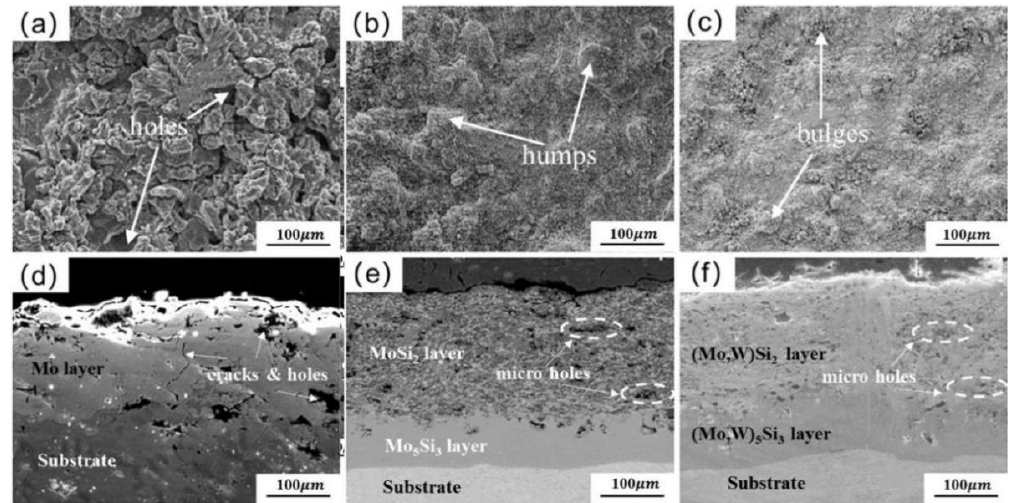
Figure 5. SEM images of coatings prepared by SPS under different procedures: ( a , d ) Pure Mo coating; ( b , e ) MoSi 2 -mullite coating; ( c , f ) WSi 2 -mullite-MoSi 2 coating.